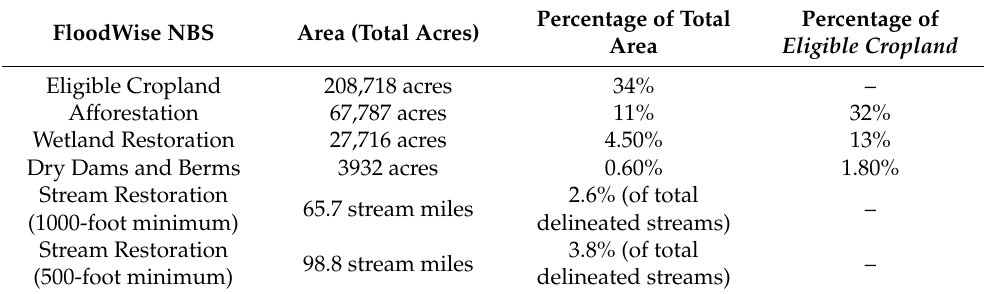
Figure 15. Stream restoration opportunity areas with a 1000-foot minimum length (with adjacent open land requirement) in Robeson County. Table 3. Table summarizing results of FloodWise NBS opportunity area